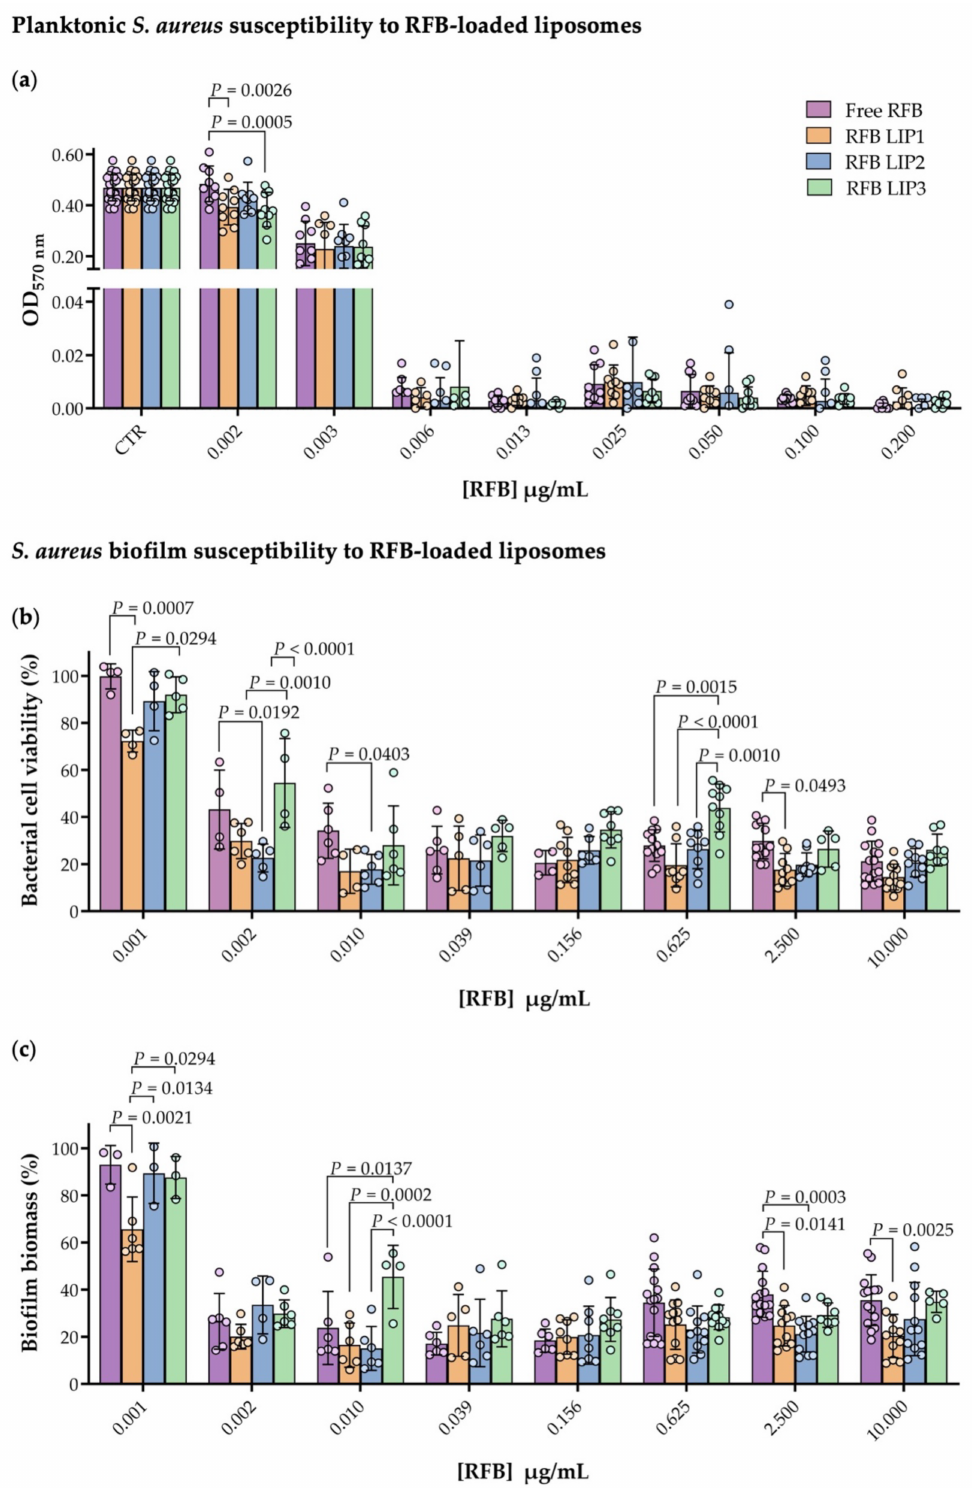
Figure 3. ( a ) In vitro planktonic MSSA susceptibility to free and liposomal RFB assessment through broth microdilution method, followed by turbidity measurement (OD 570 nm ), RFB concentrations tested ranged from 0.002 to 0.200 µ g/mL. The negative control corresponds to planktonic MSSA in MHB (CTR). ( b ) Determination of viable bacterial cells (MTT assay) and ( c ) biofilm biomass quantification (CV method) after mature MSSA biofilm incubation with a RFB concentration ranging from 0.001 to 10.000 µ g/mL. Statistical comparisons were determined by two-way ANOVA (Tukey’s multiple comparisons test) analysis of variance compared between formulation groups. Results are expressed as mean ± SD of at least three independent